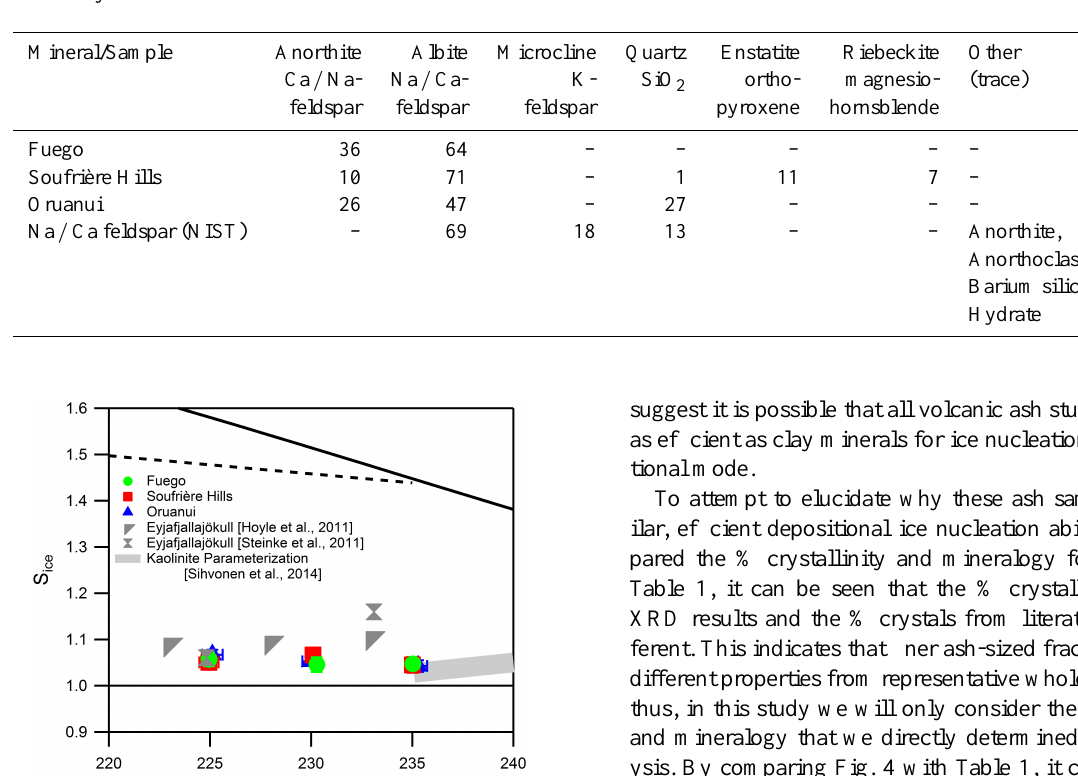
Table 2. The mineralogical composition of Fuego, Soufrière Hills, and Oruanui volcanic ash and NIST SRM-99b Na / Ca feldspar as determined by XRD.